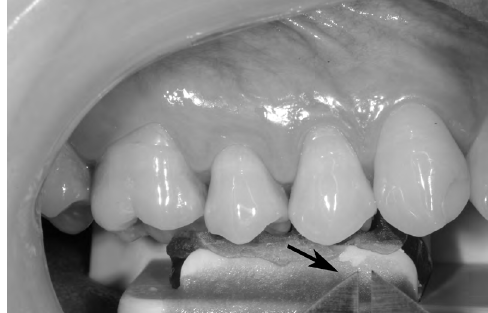
Figure 3. Intra-oral photograph. Note the ends of the digital caliper (arrow) fixed with opening of 1.0 mm for the calibration of the ImageJ software (version 1.47a). Calibration was performed informing how 1.0 mm corresponded to pixels in each image, calculating the total visible surface area (mm 2 ) of the buccal surface through the perimeter contour of the teeth (clinical crowns).